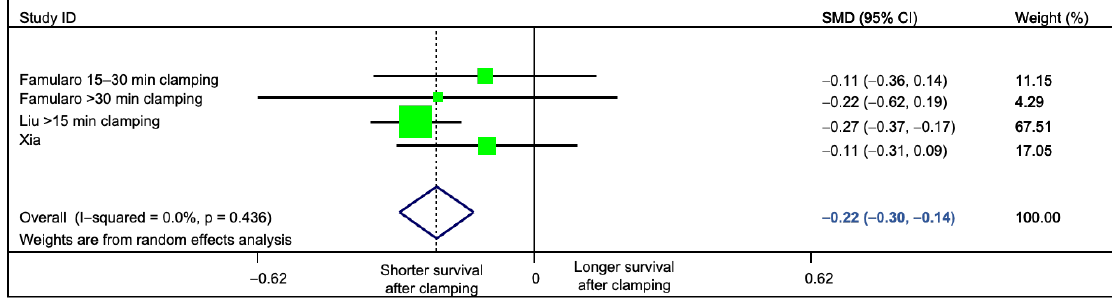
Figure 5. Sensitivity analysis, evaluating the impact of clamping time on the measured statistical heterogeneity. Only studies comparing prolonged (≥ 15 min) clamping time versus no-clamping were pooled. Residual heterogeneity was 0%.